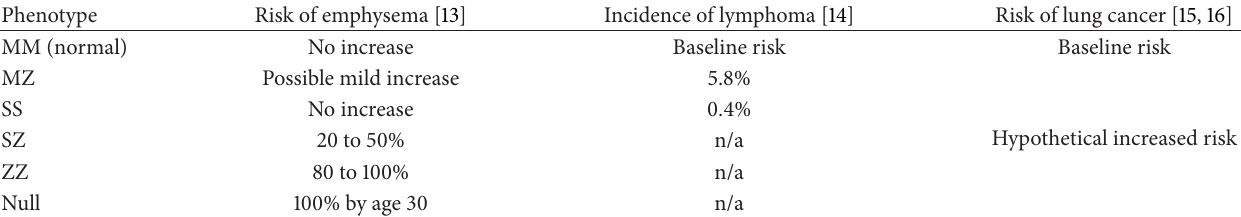
Table 3: Correlation between ATT phenotype and emphysema, lymphoma, and lung